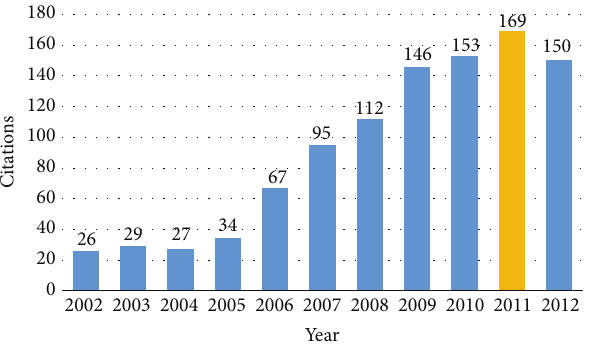
Figure 1: Computer Fraud and Abuse Act (CFAA) in the courts